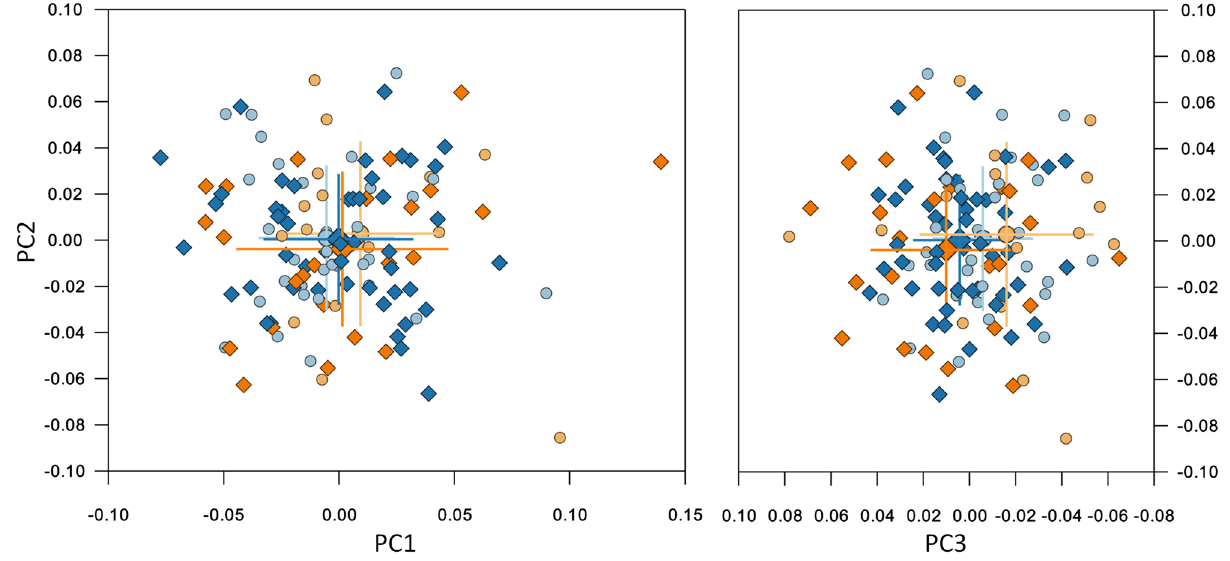
Figure 6. Shape space of the CrB region. Blue and light blue: control subjects; orange and light orange: βTh group. Circles: females; diamonds: males. Large markers show group means and standard deviation.